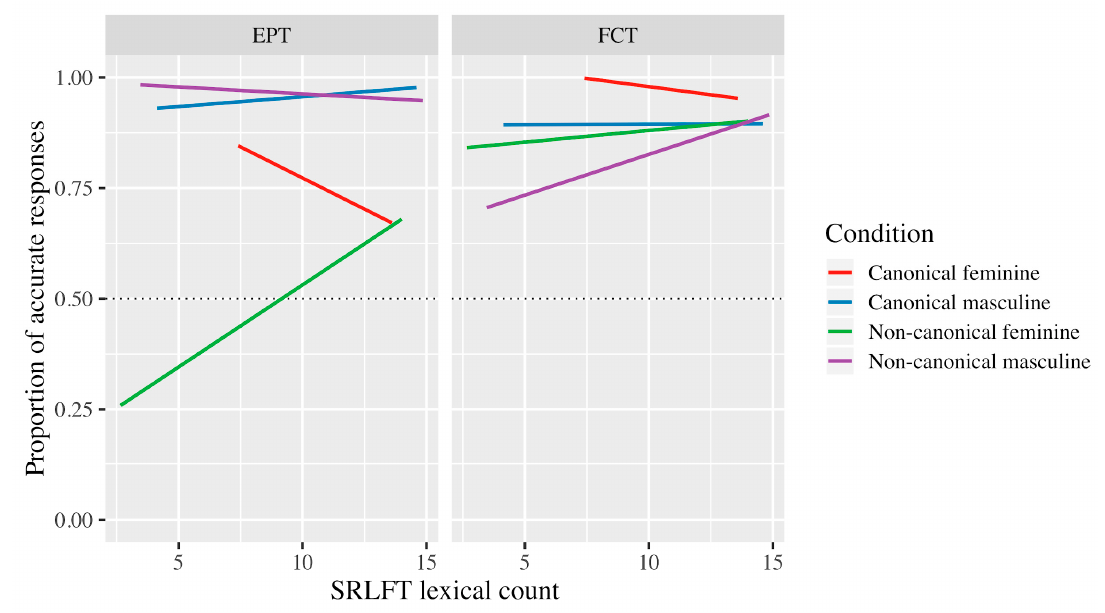
Figure 2. Self-rating lexical frequency task (SRLFT) lexical count and accuracy in gender assignment and agreement.